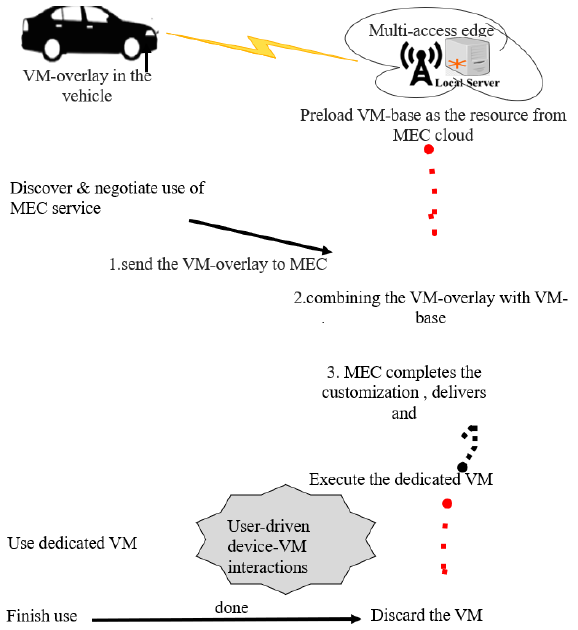
Figure 3. Dynamic VM synthesis approach to instantiate a VM for a cloud service at MEC